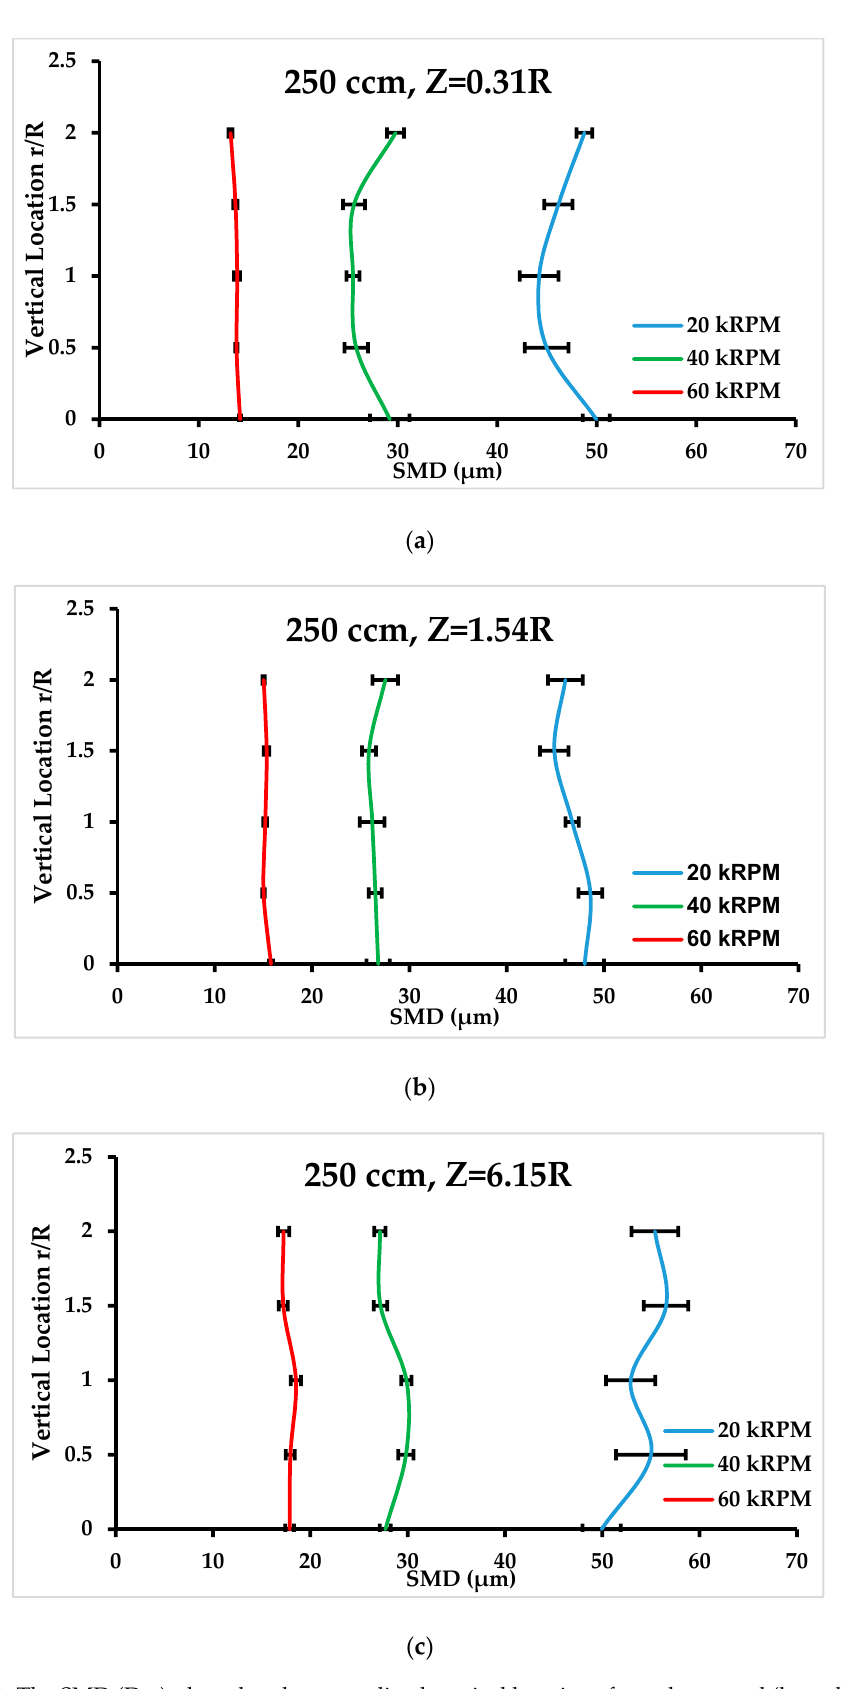
Figure 8. The SMD (D 32 ) plotted at the normalized vertical locations from the central (lateral) axis of the spray flow field, at different rotational speeds for a fixed fluid flow rate of 250 ccm.